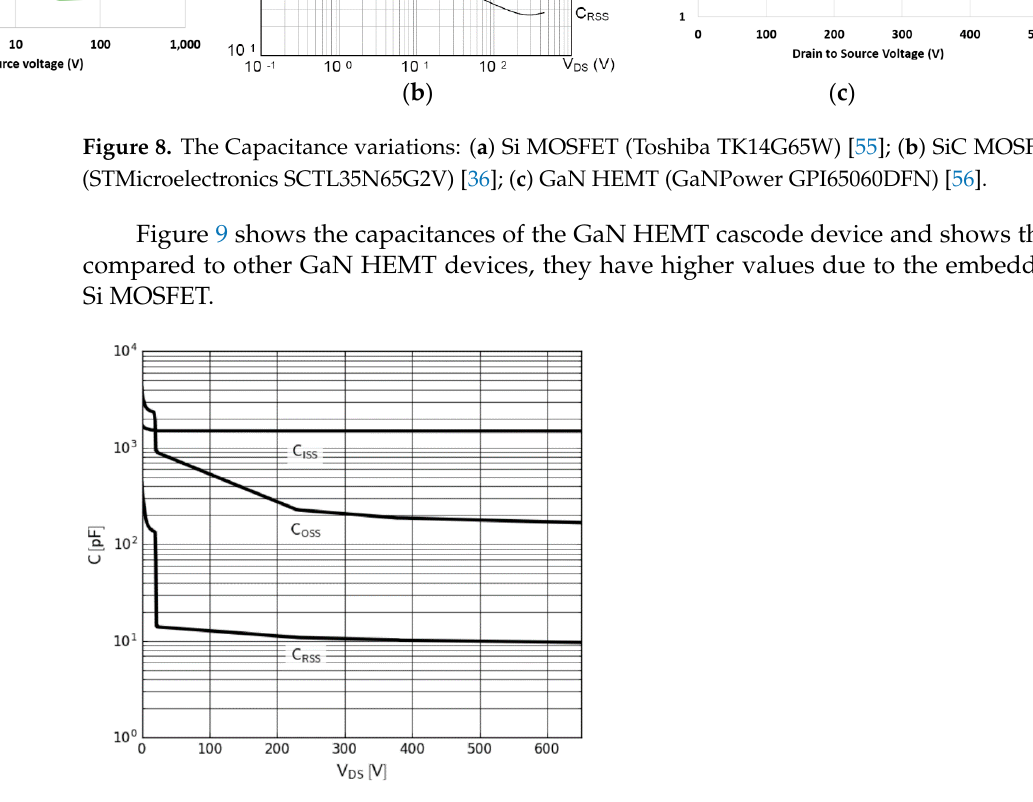
Figure 9. The capacitance of GaN HEMT cascode (Transphorm TP65H035WS) [57].